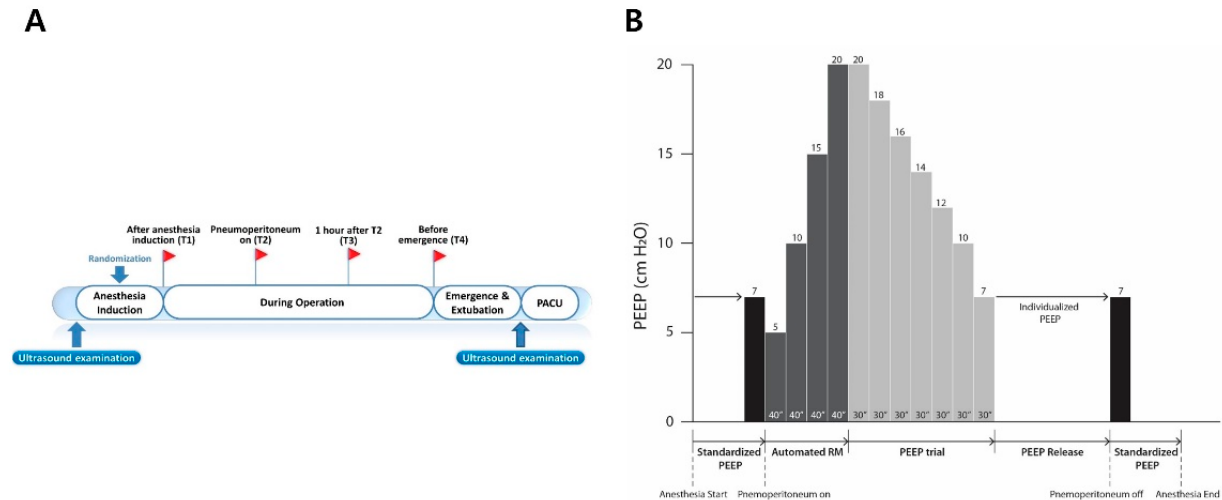
Figure 1. Study protocol. ( A ) Four predefined time points (T1–T4) when intraoperative ventilatory parameters were recorded and arterial blood gas analysis was performed and two time points of ultrasound examination. ( B ) The protocol of recruitment maneuver and decremental PEEP trial in the individualized group. These protocols were performed just before T2. This recruitment maneuver was also performed in the standardized group. RM = recruitment maneuver.